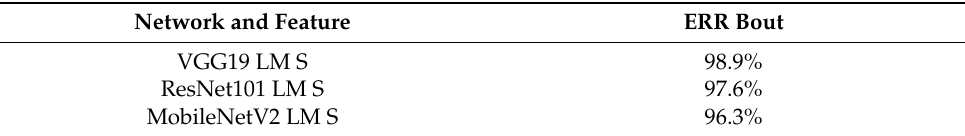
Table 7. Performance of other CNN topologies.